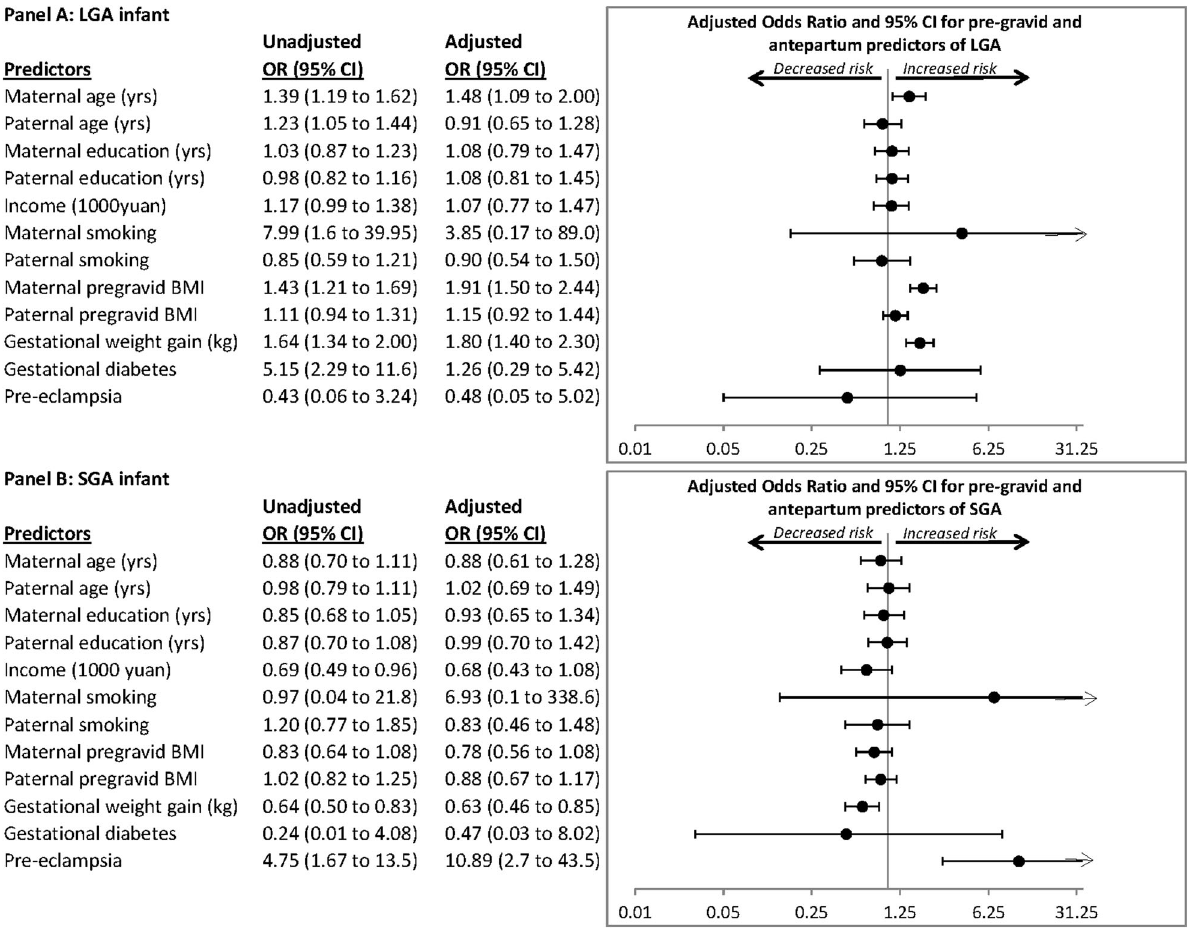
Fig. 1 Predictors of large-for-gestational age and small-for-gestational age. Pregravid and antepartum predictors of ( A ) delivering a large- for-gestational-age (LGA) infant and ( B ) delivering a small-for-gestational-age (SGA) infant. Data were presented as odds ratio per standard deviation change in the indicated variable, either unadjusted or after adjustment for all of the other listed